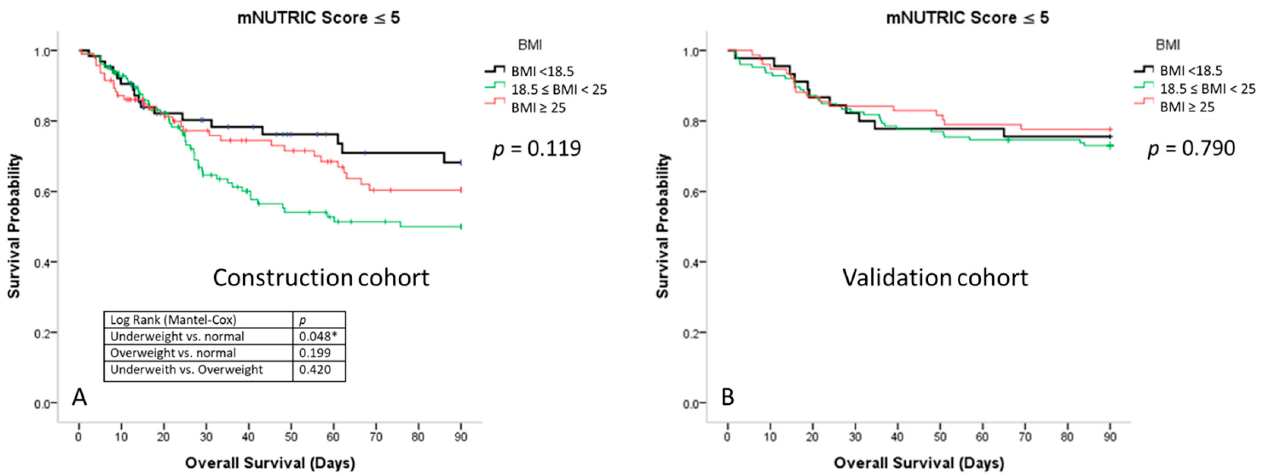
Figure 4. ( A ) Survival curves for the patients with sepsis in the medical intensive care unit who had low mNUTRIC scores ( ≤ 5) according to body mass index in the construction cohort; ( B ) survival curves for the patients with sepsis in the medical intensive care unit who had low mNUTRIC scores ( ≤ 5) according to body mass index in the validation cohort. * The 90-day survival rate of the underweight group with low mNUTRIC scores was significantly higher than that of the normal-weight group with low mNUTRIC scores (70.8% ± 4.2% vs. 58.3% ± 3.3%, respectively; p =